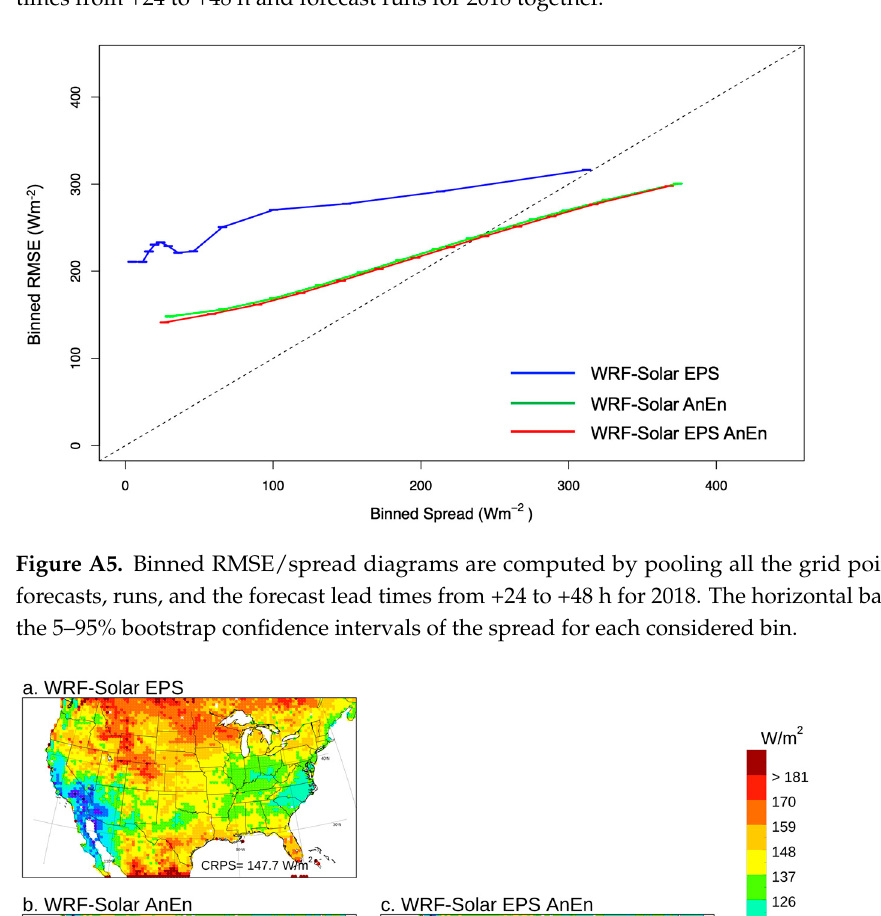
Figure A4. RMSE/spread ratio computed for all the grid points for DNI by pooling the forecast lead times from +24 to +48 h and forecast runs for 2018 together.